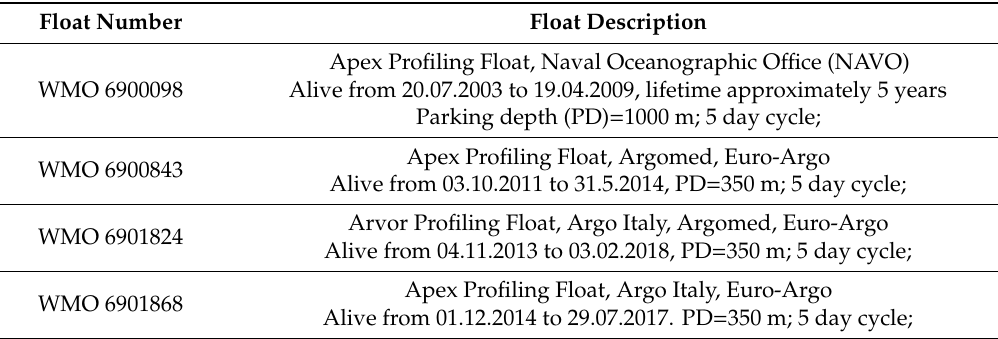
Table 2. Argo floats capturing pronounced (MLD > 250 m) dense water formation events.